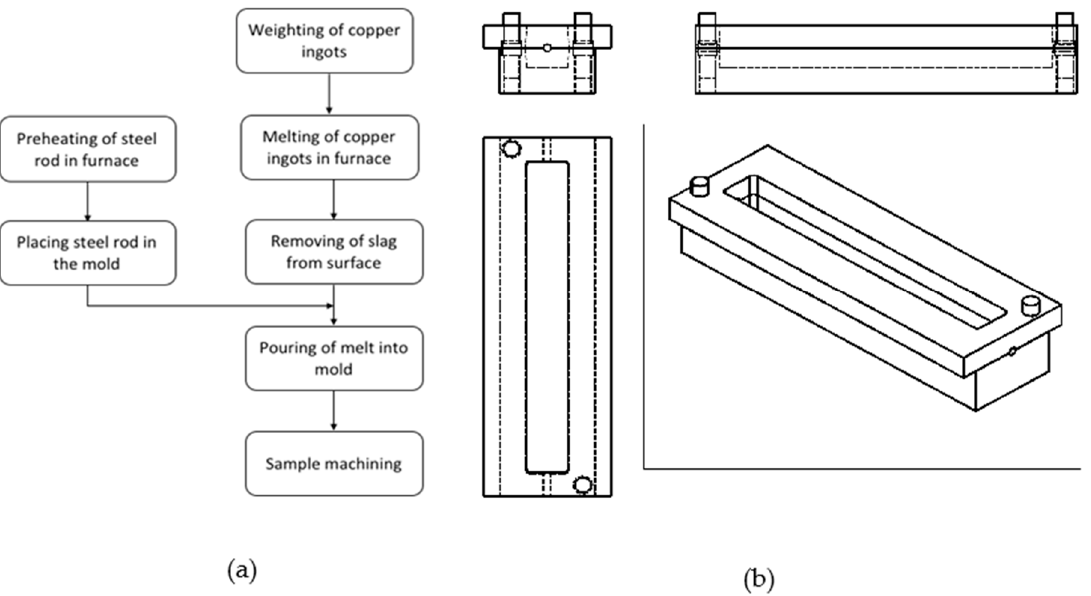
Figure 1. ( a ) Flowchart of foundry process used to prepare QMMC; ( b ) D2 steel mold used to make QMMC samples.